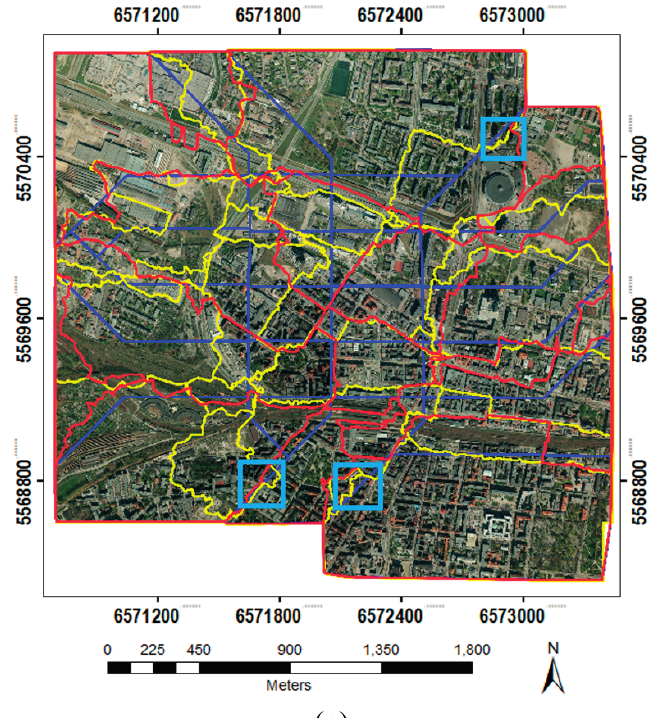
Figure 11. Mosaic results of the three methods for Dataset 1. ( a ) Overview of the mosaicked images. The blue lines are the seamlines constructed through the geometry-based method; the yellow lines are the seamlines constructed through the gray-based method; and the red lines are the seamlines constructed through the OESM-based method. ( b ) Detailed seamlines in the cyan rectangular areas of (a) selected through the three methods. The orange circle marks the visual continuities from the